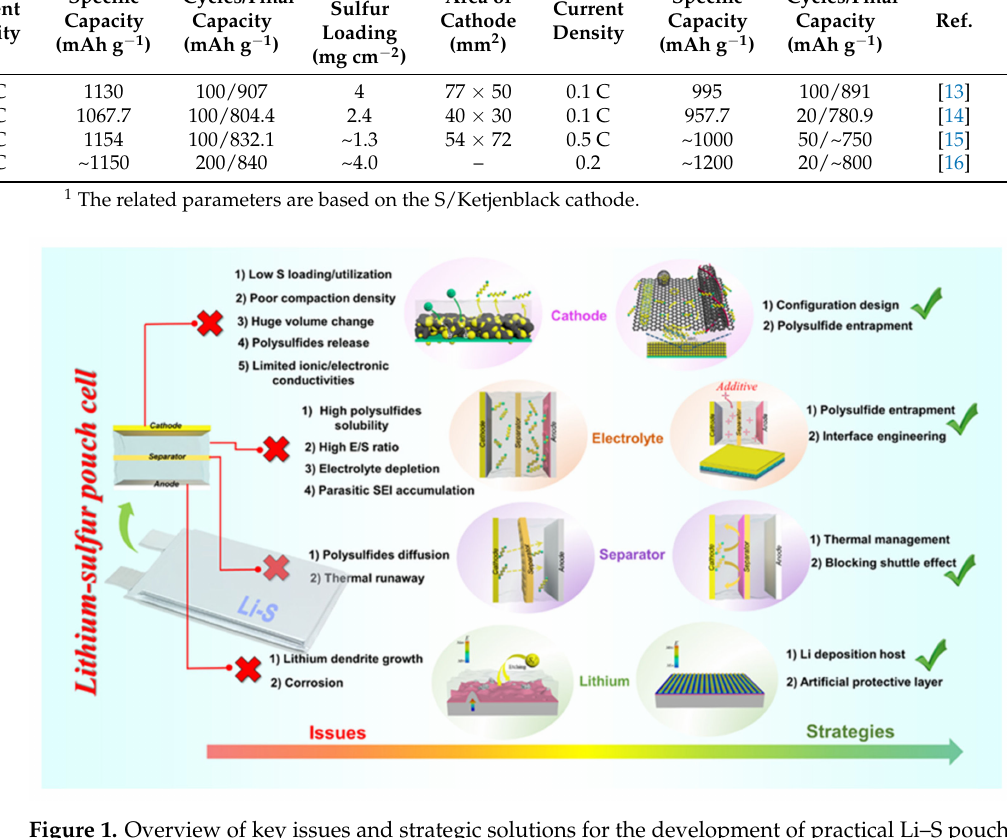
Figure 1. Overview of key issues and strategic solutions for the development of practical Li–S pouch cells